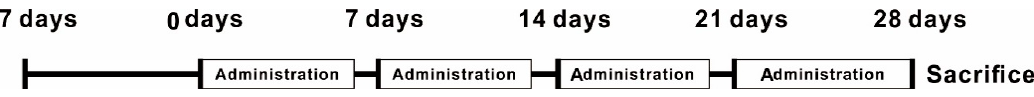
Figure 1. Protocol for the In Vivo test. Fifty male rats were acclimatized to the environmental conditions for 7 d after receipt and were then divided into four groups ( n = 12 or 13). Each treatment (e.g., B-3L or B-3HK) was orally administered for 4 weeks. Body weight and food intake were monitored